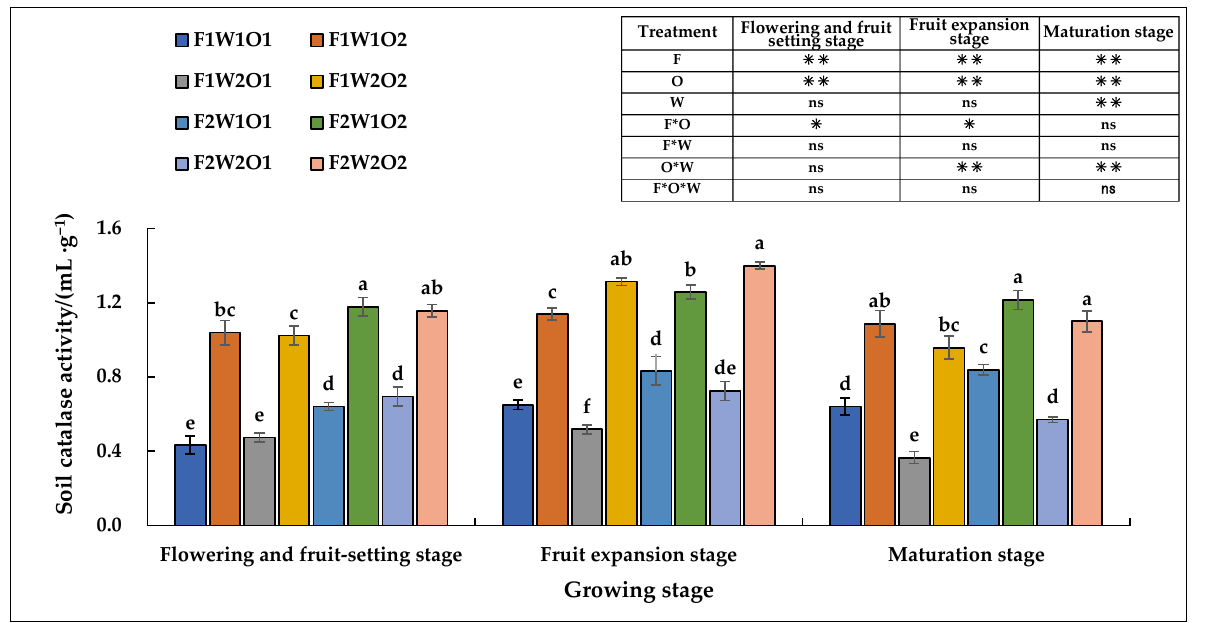
Figure 4. Analysis of variance of soil catalase activity in the tomato root zone under different treatments. Note: F represents the fertilizer amount, O represents the oxygen amount, W represents the irrigation amount. Different letters indicate significant differences at the level of p < 0.05. * p < 0.05. ** p < 0.01. ns, not significant at p < 0.05.